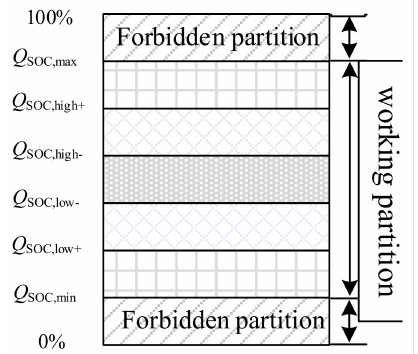
Figure 2. Schematic of energy storage battery SOC partition. (1) Q SOC (t) ∈ [0%, Q SOC , min ] or [ Q SOC , max